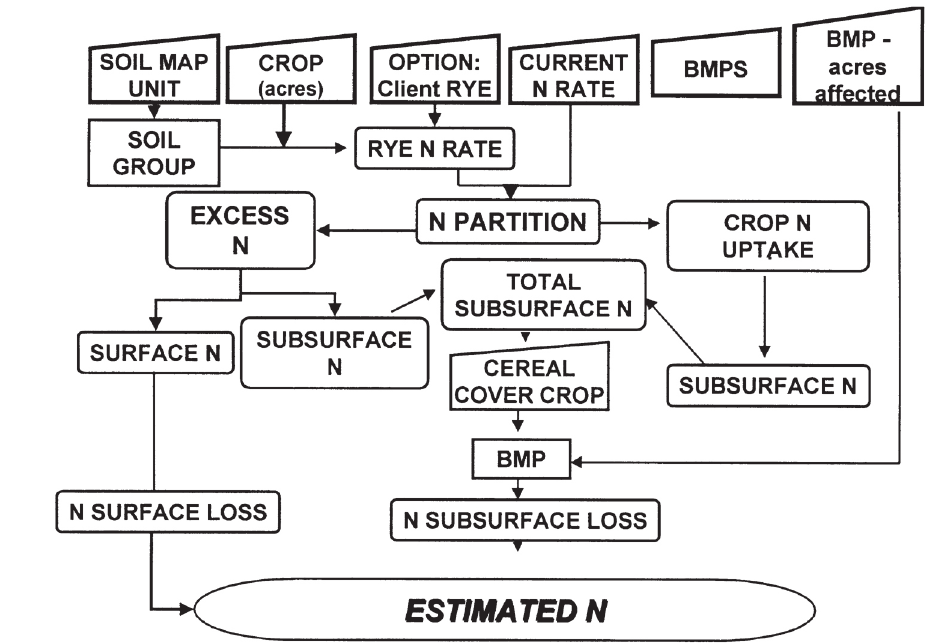
FIGURE 1 . Schematic of field-scale